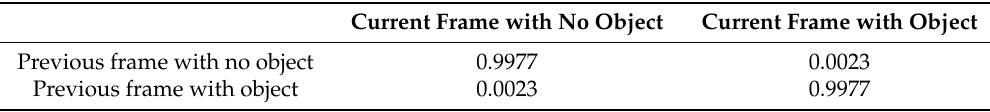
Table 7. State transition